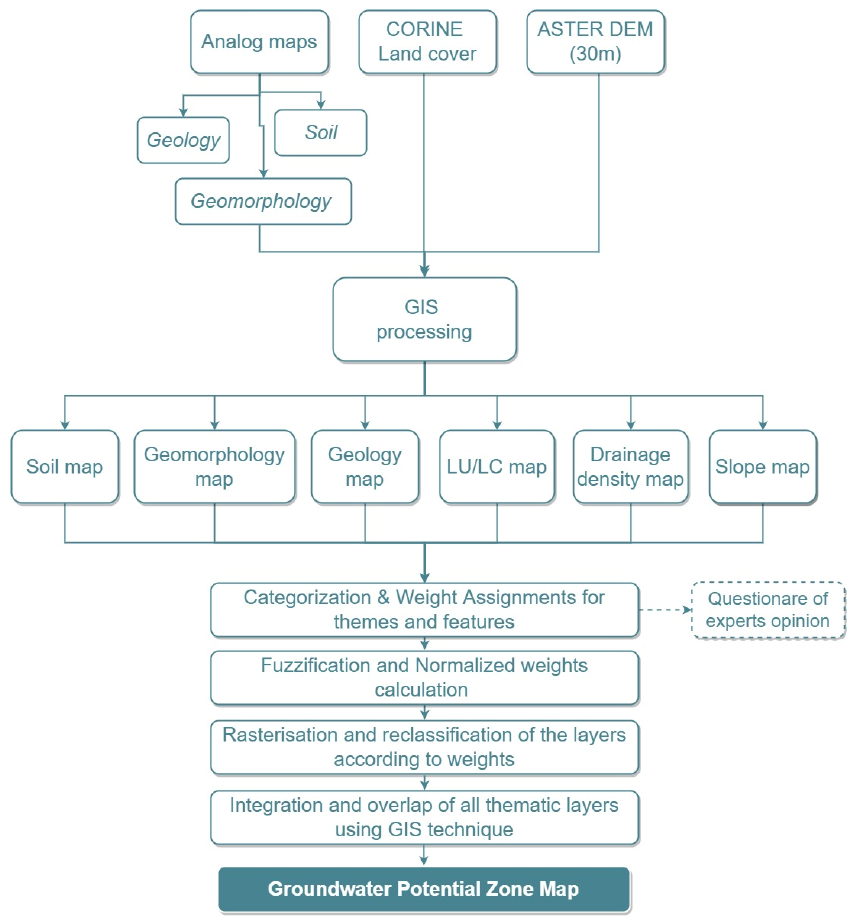
Figure 2. Methodological flow chart used in this study.